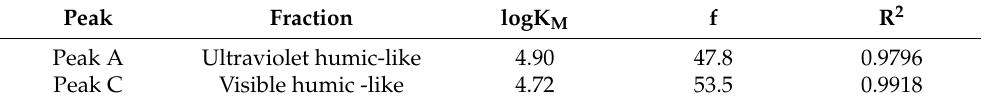
Table 2. The initial proportion and the conditional stability constant of each fluorophore in PPFA. Peak Fraction logK M f R 2 Peak A Ultraviolet humic-like 4.90 47.8 0.9796 Peak C Visible humic -like 4.72 53.5